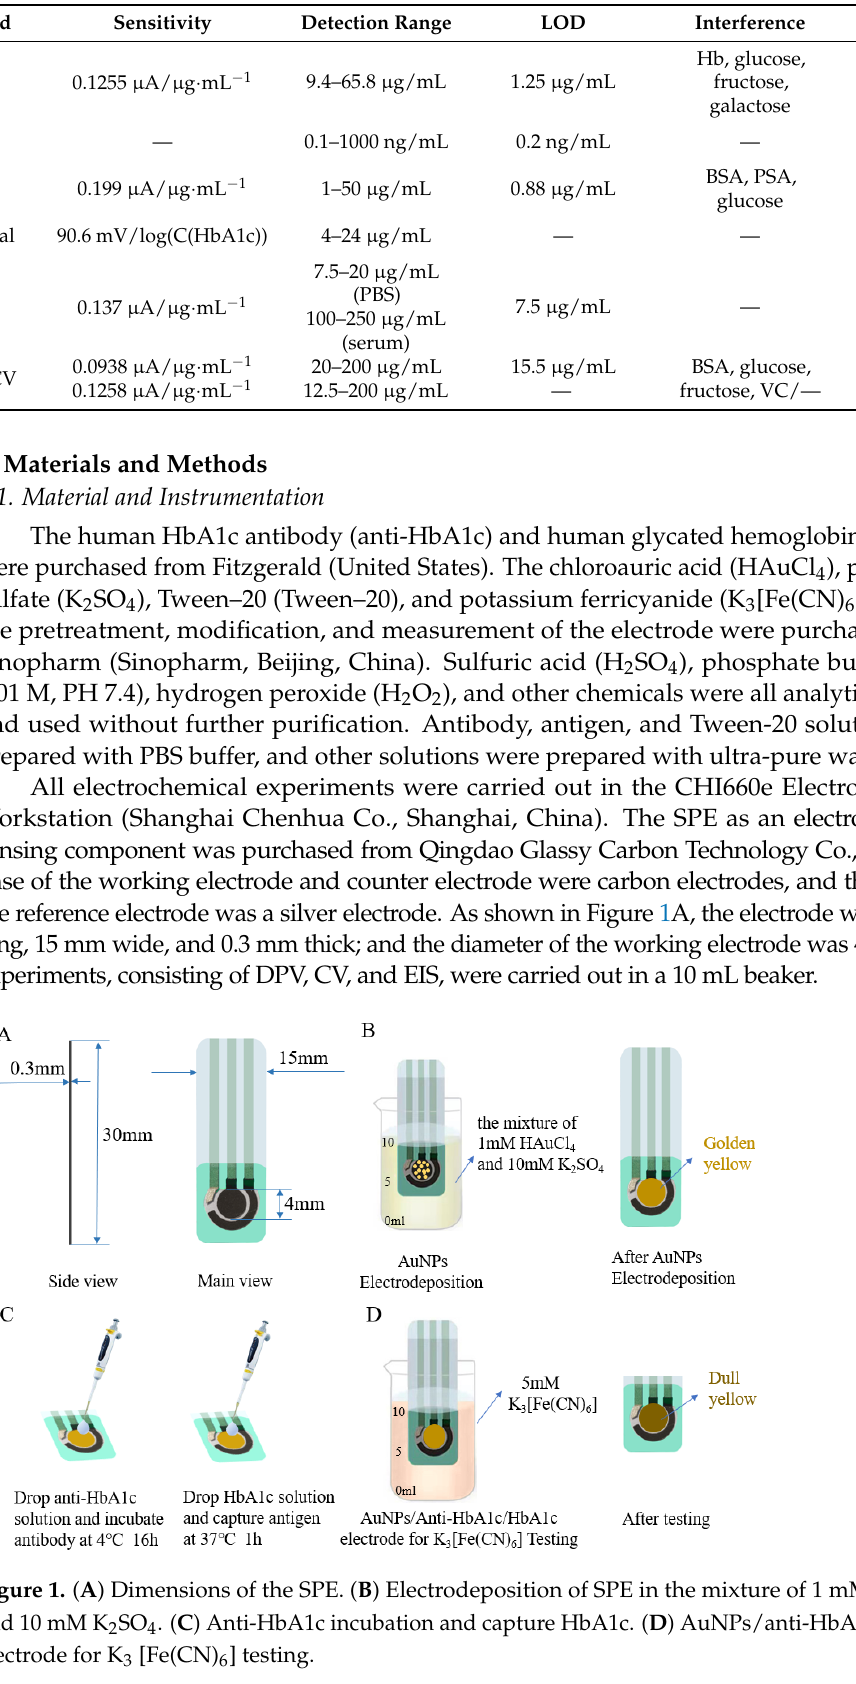
Table 1. Analytical Parameters for the Detection of HbA1c by Several Methods.